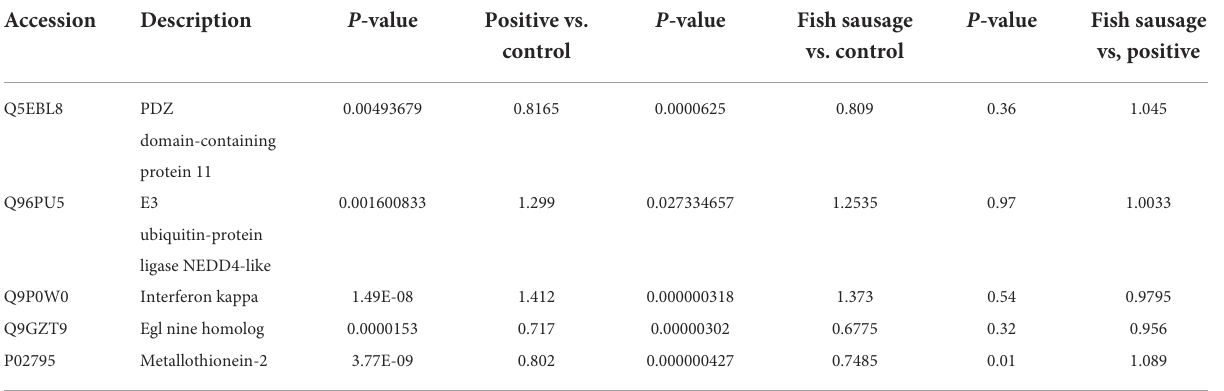
TABLE 6 The comparison of the main differential proteins among the three